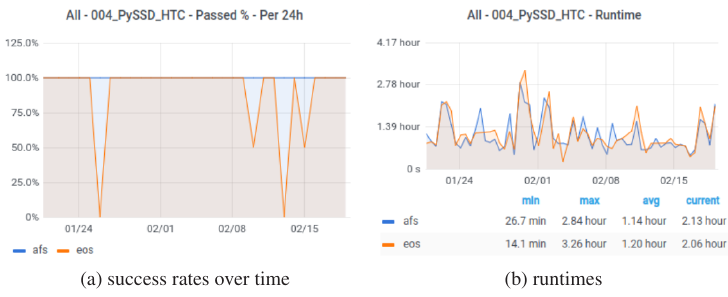
Figure 4: example of a complex testcase on both AFS and